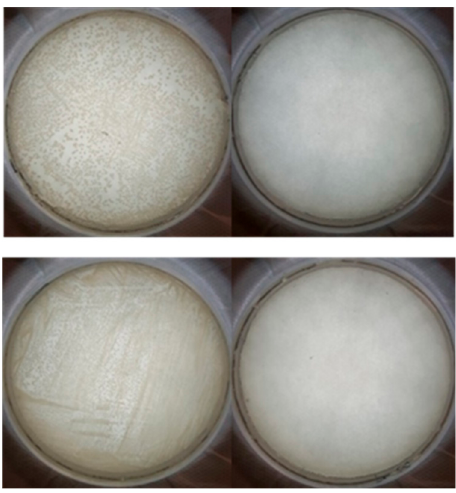
Figure 5. Photos of the petri dishes containing E. coli (upper photos) and S. aureus (lower photos) cultures. The petri dishes on the left have been exposed to uncoated QCM-D crystals, while those on the right have been exposed to (Naf/Lys) 6 coated discs, under otherwise identical conditions.